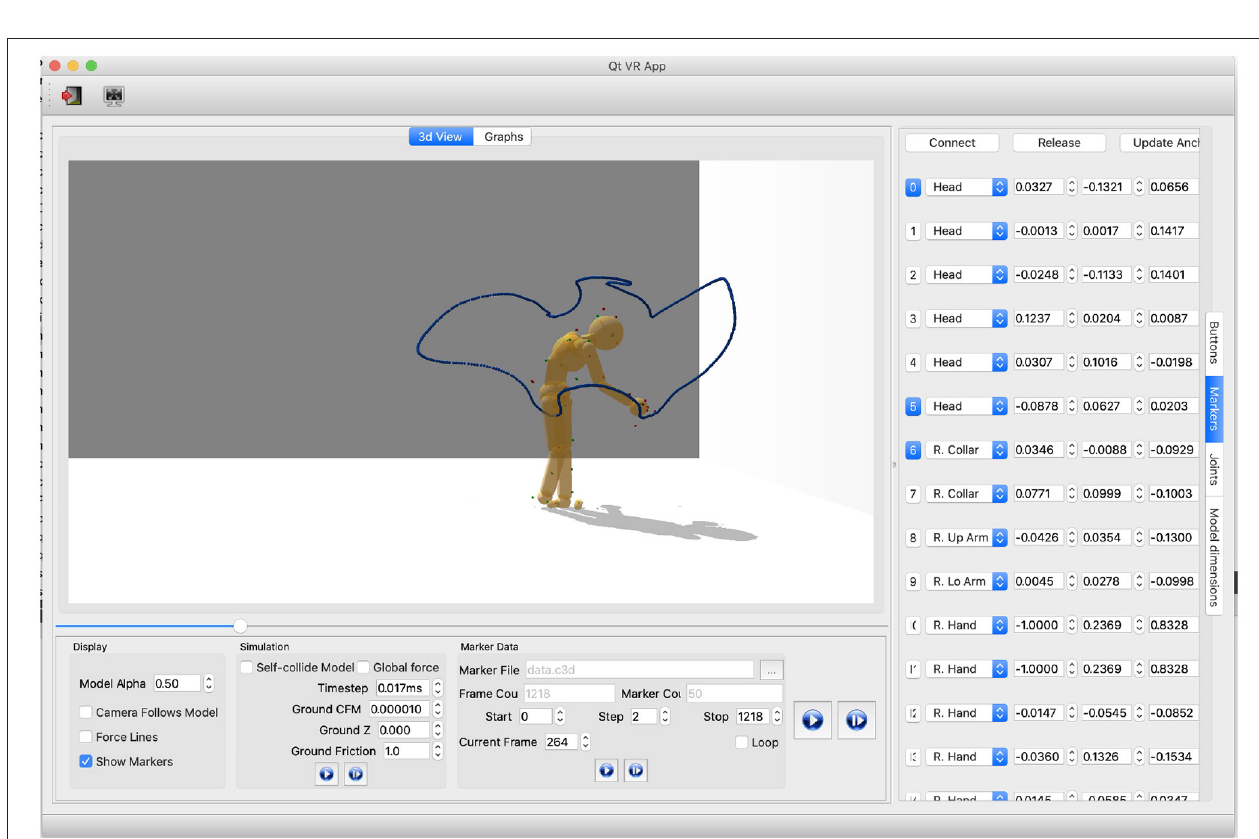
FIGURE 4 | Model capability illustration. A complex jump sequence reproduced with physics-engine-based inverse dynamics using recorded motion capture data from a human subject. The recreated jump height is achieved completely from ground forces, augmented with small residual torques ( ≤ 100 Nm), allowing the model to maintain balance.